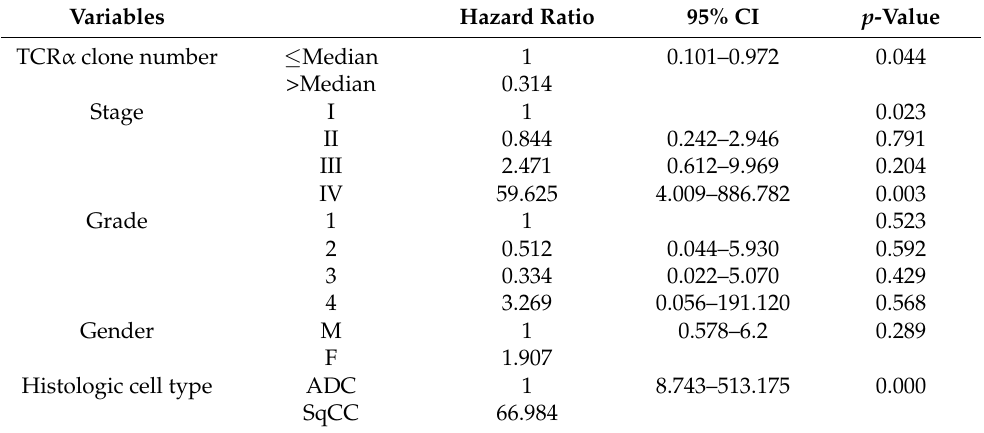
Table 1. Multivariate analysis (Cox regression) of independent prognostic factors in patients with lung